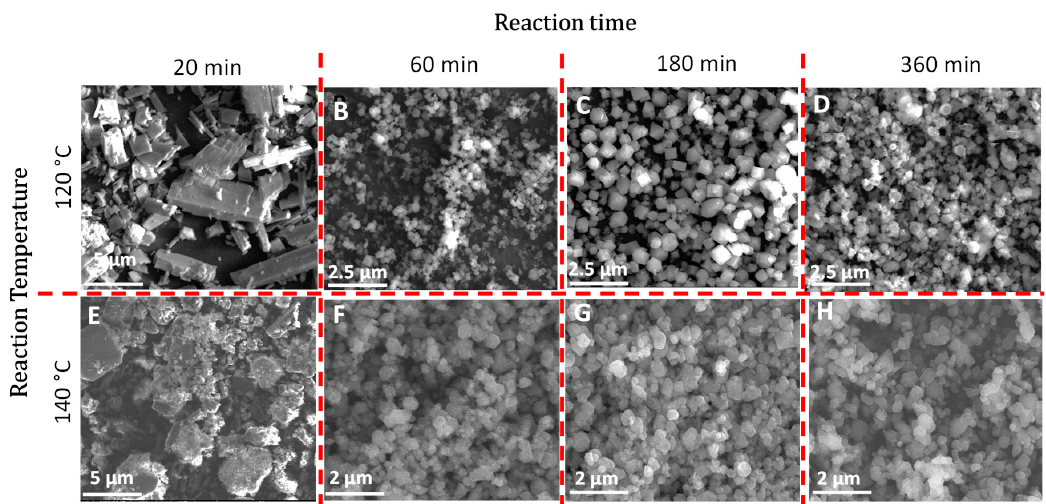
Figure 2. Scanning Electron Microscopy (SEM) images of Cu(II)BTC fabricated using dodecanoic acid as a modulator at various reaction temperature and time. Synthesized MOFs at 120 °C are shown in images A-D representing 20, 60, 180 and 360 min of reaction time respectively. The corresponding times at 140 °C are shown in images E-H.